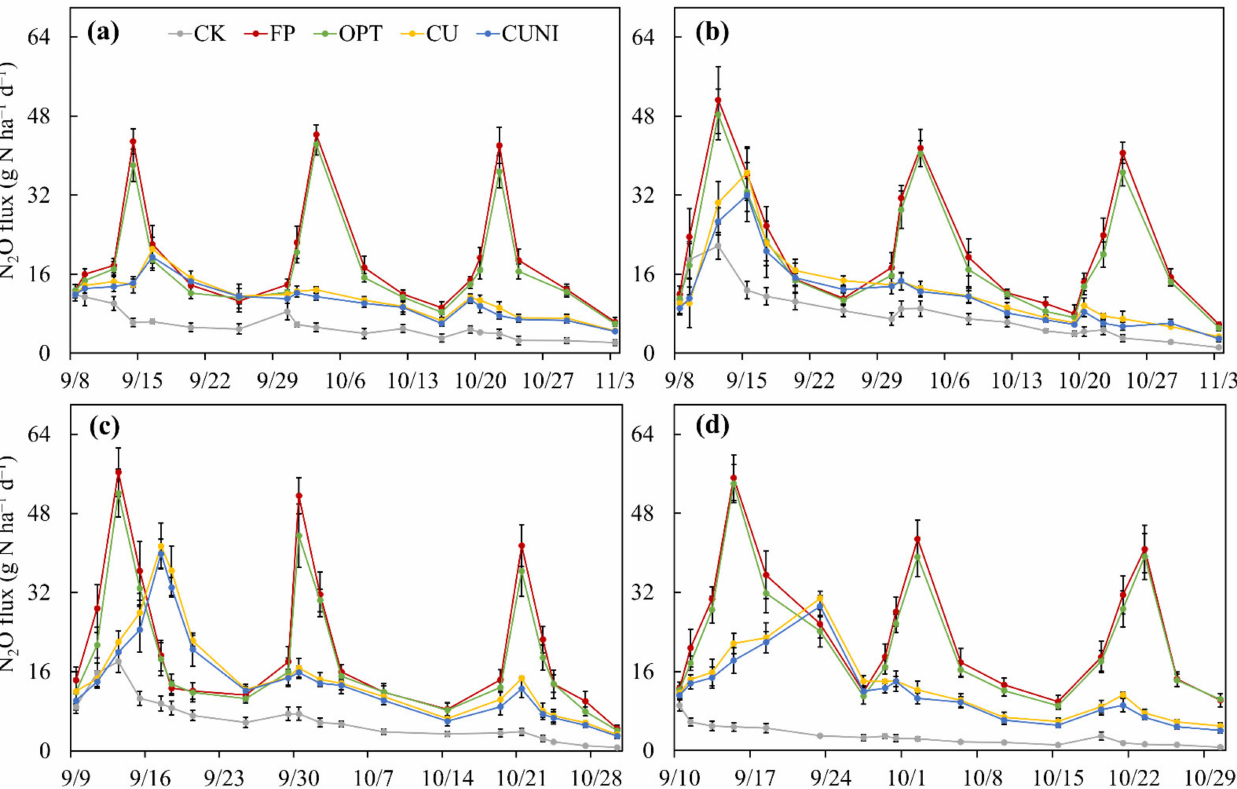
Figure 3. Soil N 2 O fluxes during the lettuce growing seasons in 2017 ( a ), 2018 ( b ), 2019 ( c ) and 2020 ( d ). CK, no N fertilizer; FP, conventional urea based on local farmers’ practices; OPT, conventional urea at reduced N rate; CU, polyurethane-coated urea at reduced N rate; CUNI, polyurethane-coated urea at reduced N rate in combination with NI. Bars represent standard deviations ( n =